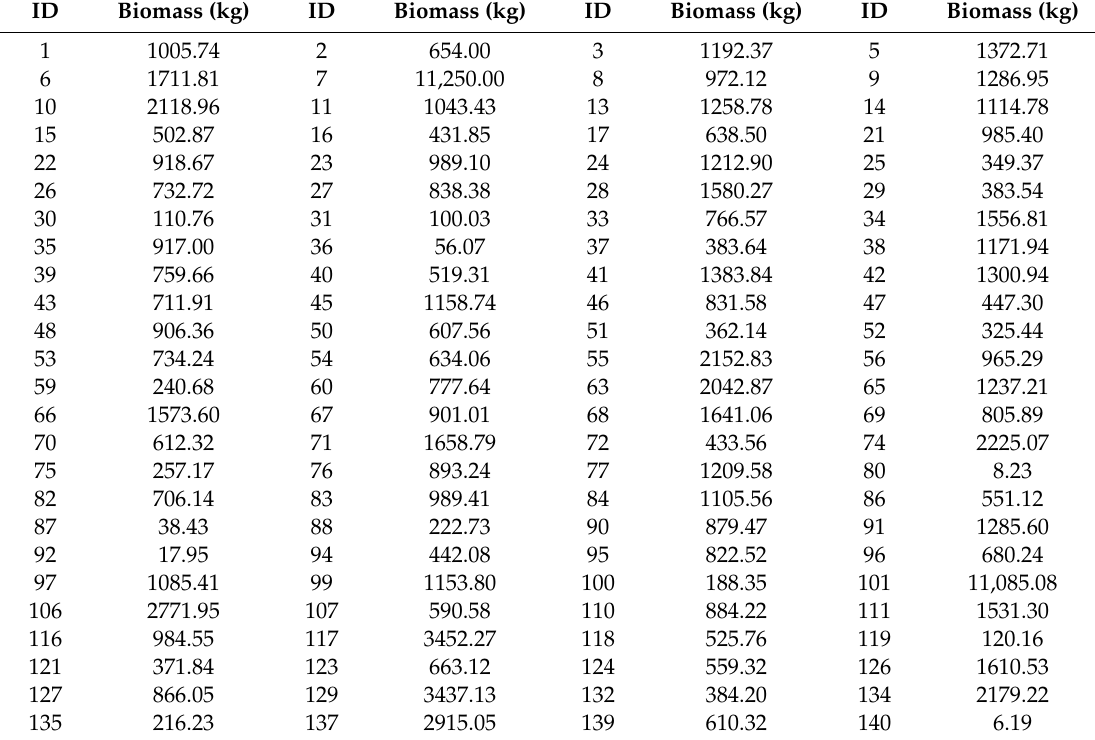
Table A4. The calculated biomass for each quadrat. As only 140 of the 192 pre-selected quadrats were visited and investigated, the quadrat ID ranges from 1 to